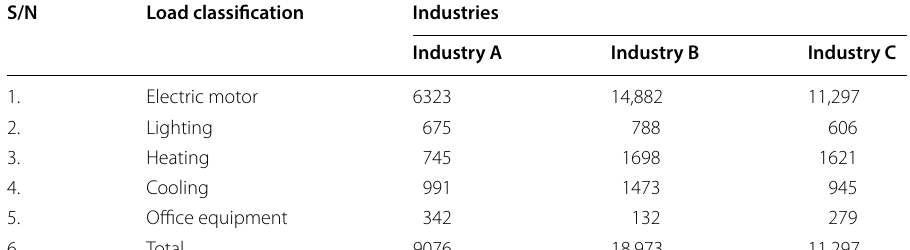
Table 2 Estimated electrical energy consumption by load class obtained through energy audit (kW h)